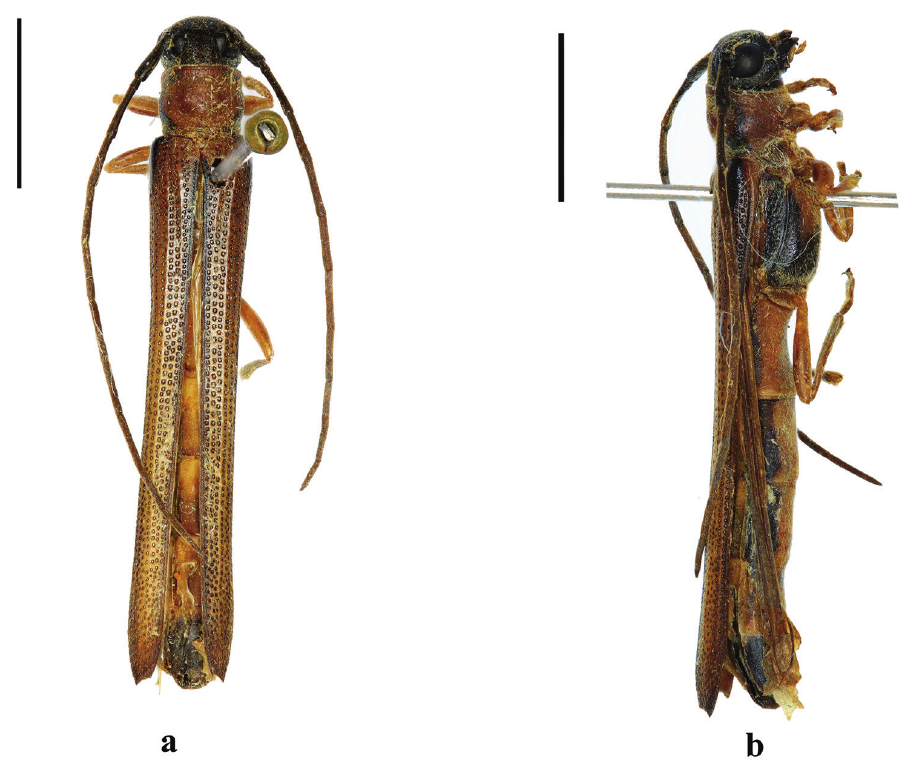
Figure 9. Habitus of O. brevithorax Gressitt, 1936, male, from Tonkin, a dorsal view b lateral view. Scale bar 5.0